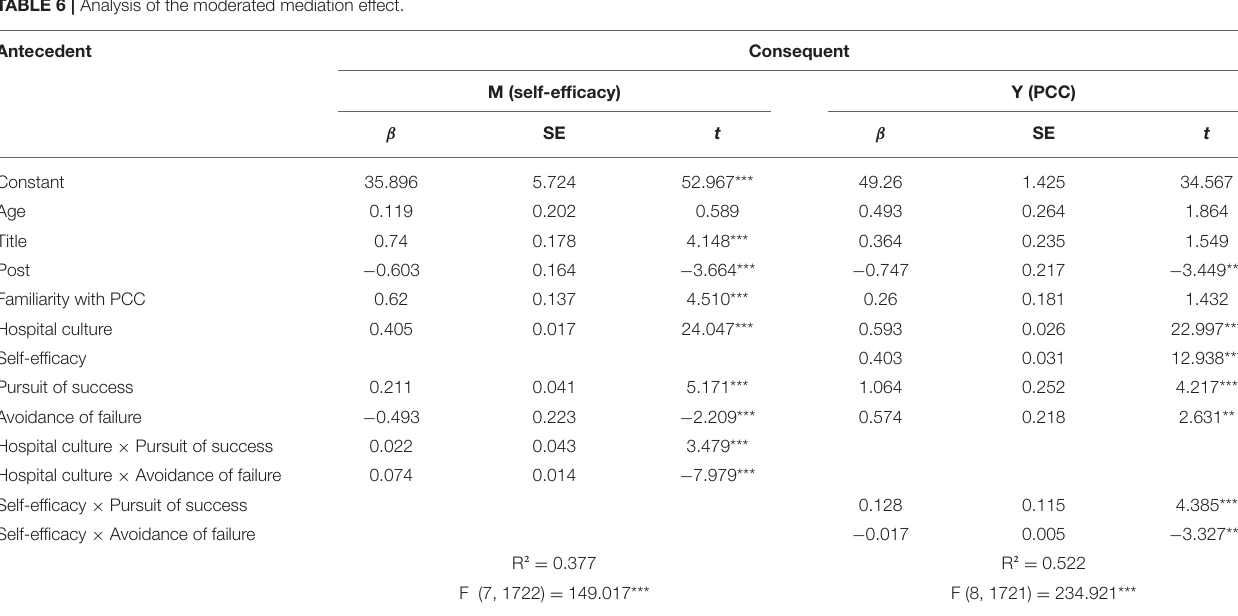
TABLE 6 | Analysis of the moderated mediation